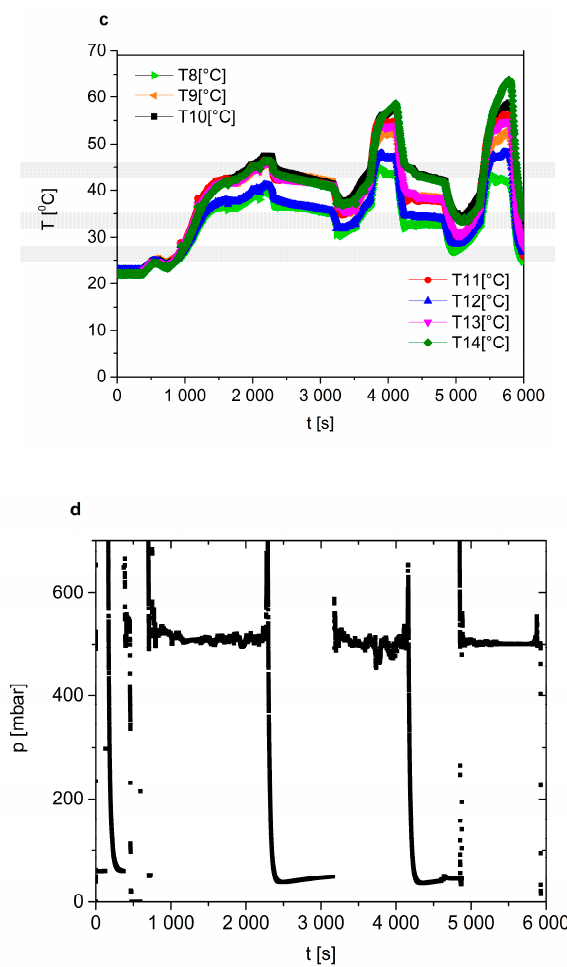
Figure 13. ( a ) Variation in voltage (U), current (I), and power (P) of a PEMFC stack vs. time, recorded during operation under variable electrical load. ( b ) Temperature distribution in module (A) during operation of a V-type PEMFC stack according to the conditions presented in (a). ( c ) Temperature distribution in module (A) during operation of a V-type PEMFC stack according to the conditions presented in (a). ( d ) Stabilisation of partial pressure H 2 during introduction of fuel into a V-type PEMFC stack.